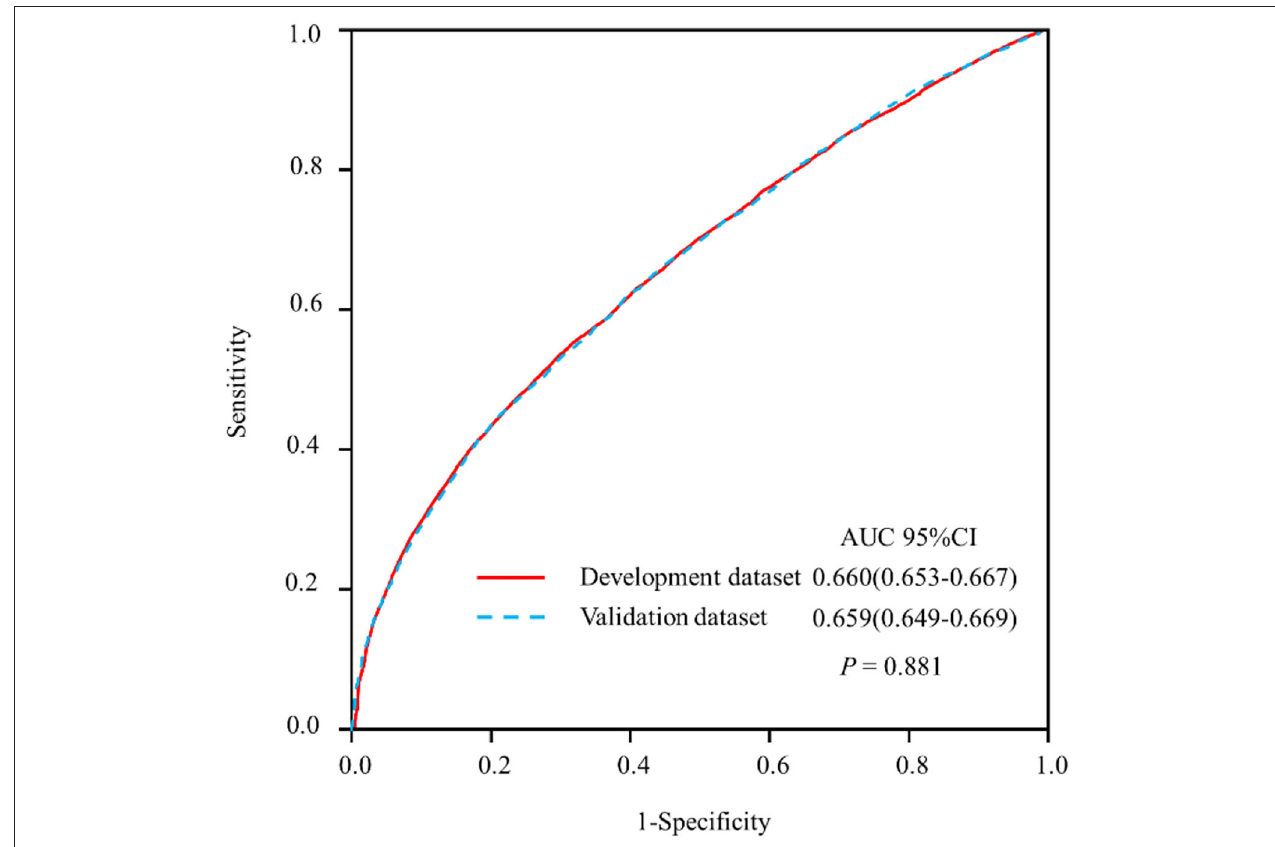
FIGURE 4 | Receiver operating characteristic curve (ROC) analyses of predictors for the family doctor contract service in the development and validation datasets.